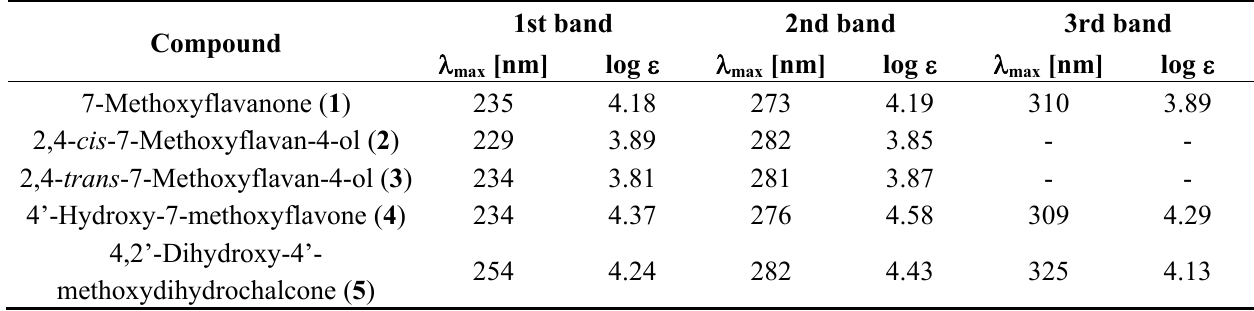
Table 4. UV absorption of 7-methoxyflavanone ( 1 ) and its biotransformation products ( 2 – 5 ).